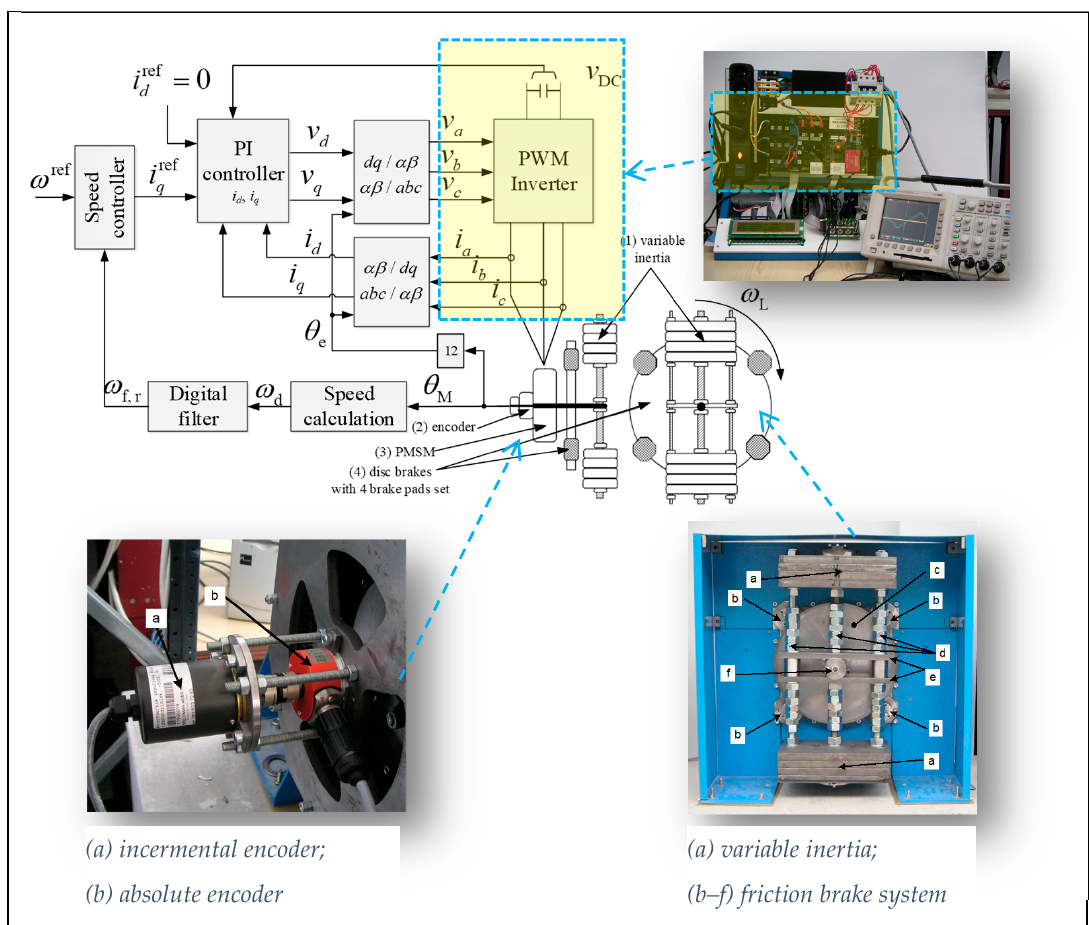
Figure 1. Laboratory stand setup and schematic.